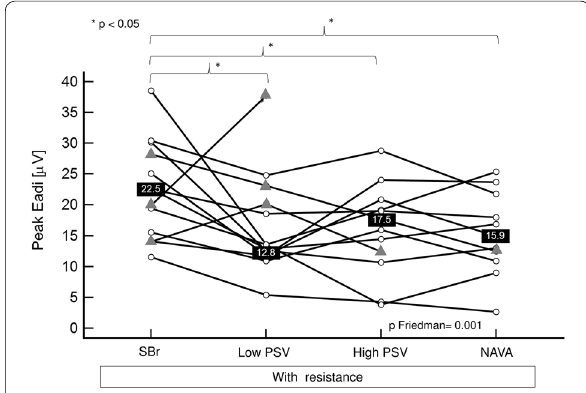
Fig. 5 Effect of stressed assisted ventilation on peak electrical activity of the diaphragm (peak Eadi). SBr stressed (with resistance) spontaneous non‑assisted breathing, PSV pressure support ventilation, NAVA neurally adjusted ventilatory assist. The data of all the participants are displayed in the figure. Patients for whom all the conditions were available are represented as white circles. Patients for whom one or more conditions could not be recorded are represented as gray triangles. Only the patients represented as white circles were considered for median calculations and Friedman